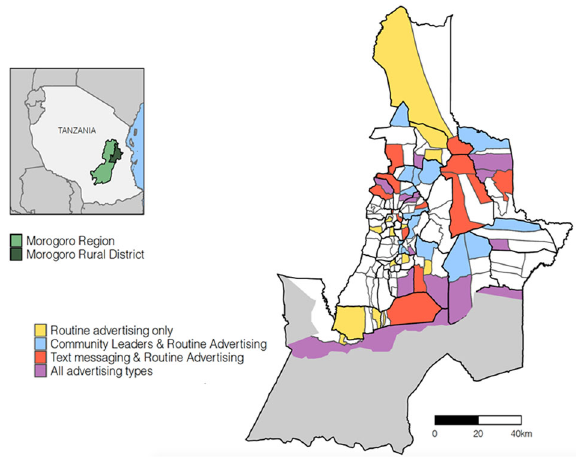
Fig. 1 Villages in the Morogoro Rural District in eastern Tanzania. All coloured villages were part of our experiment and received different advertising interventions according to the legend. White villages were not part of our study and did not receive any of our study interventions. However, vaccination campaigns in those villages were held 1 day after the villages in our study. Protected areas, which are uninhabited, are shown in grey.